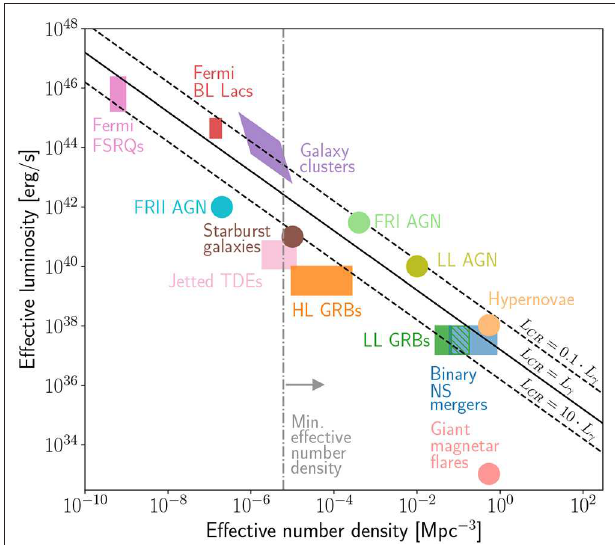
FIGURE 11 | Characteristic source luminosity vs. source number density for steady sources, and effective luminosity vs. effective number density for transient sources assuming a characteristic time spread, τ 3 10 5 yr. The = × effective number density for bursting sources is only valid for the assumed value of τ , which corresponds to mean extragalactic-magnetic-field strength of 1 nG. Stronger magnetic fields would imply larger τ and hence, larger effective number density. The black solid line gives the best-fit UHECR energy production rate derived in Aab et al. (2017d), which corresponds to 5 10 44 erg Mpc − 3 yr − 1 . The gray horizontal line gives the lower limit to the × UHECR source number density estimated in Abreu et al. (2013). For beamed sources, the “apparent” number density and luminosity are shown meaning that no beaming corrections have been applied to the luminosity or number density. The quoted characteristic luminosity and local burst rate for HL and LL GRB rates are based on the X-ray luminosity functions of Guetta and Piran (2007) and Liang et al. (2007), respectively. In the case of LL GRBs the hatched lines show that the true rate could be larger than the quoted uncertainty of Liang et al. (2007) and should be comparable to that of binary neutron star mergers. For binary neutron star mergers we used the LIGO estimate (Abbott et al., 2017b). The rate of magnetar flares quoted follows the estimate of Murase and Takami (2009). For blazars, the quoted values are based on the gamma-ray luminosity as estimated by Ajello et al. (2014), at z 0. For low-luminosity AGN, we used the median values derived in Ho = (2008) based on H α luminosities. For galaxy clusters, we used the estimated rate at z 0, based on the X-ray luminosity functions of Warren et al. (2006) = and Inoue (2011). For starburst galaxies, we used the infrared luminosity density derived in Gruppioni et al. (2013). For FRI and FRII AGN, we used the radio luminosity functions of Urry and Padovani (1995). For TDEs, the local burst rate was estimated in Sun et al. (2015). For hypernovae we quote 10 % of the kinetic energy estimate of Murase and Fukugita (2018) and the burst rate of Guetta and Della Valle (2007). F. Oikonomou for this review.